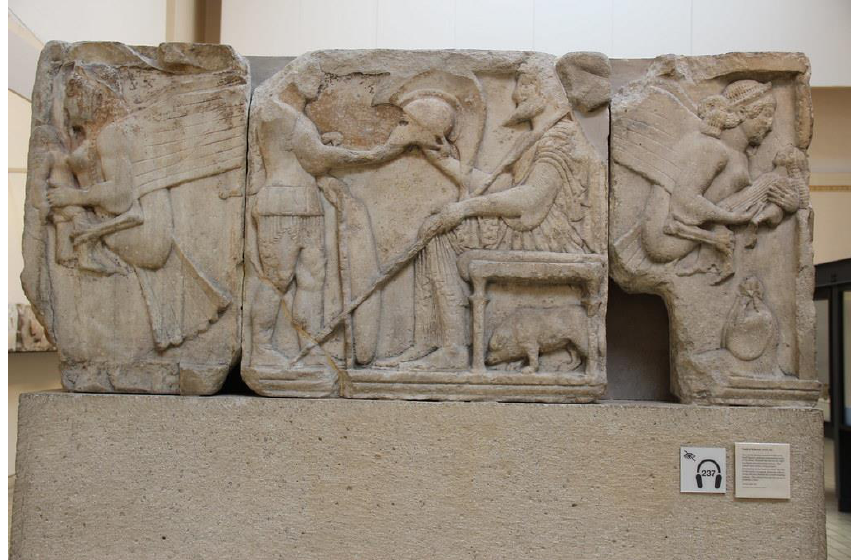
Figure 6. Winged Women, Detail from the “Harpy Tomb” (“Greek Marble Sculpture from Tomb of King Kybernis of Xanthos, 480 BC” by Gary Lee Todd, Ph.D. is licensed under CC PDM 1.0).